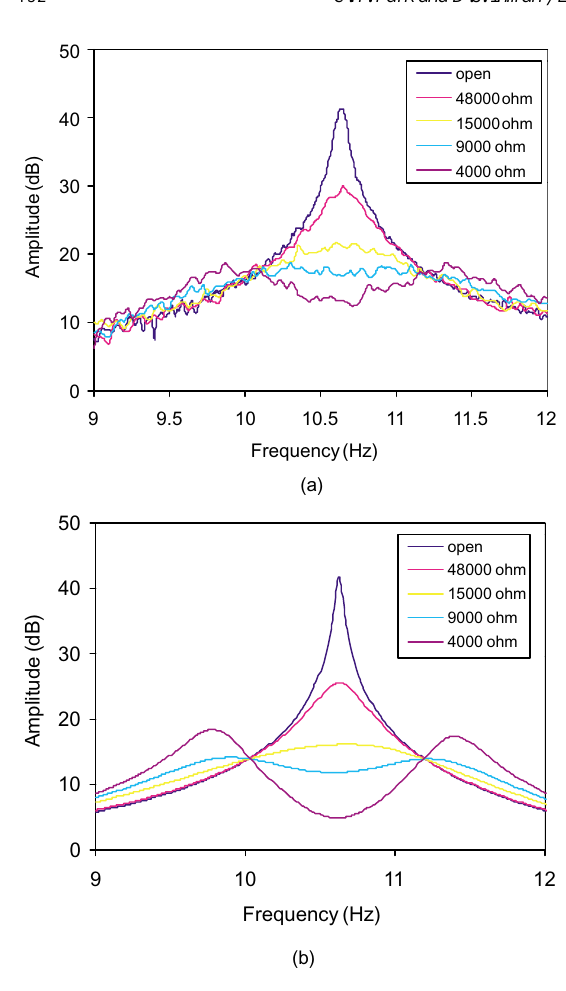
Fig. 7. Frequency response curve with full inductance (890H): (a) experiment and (b)